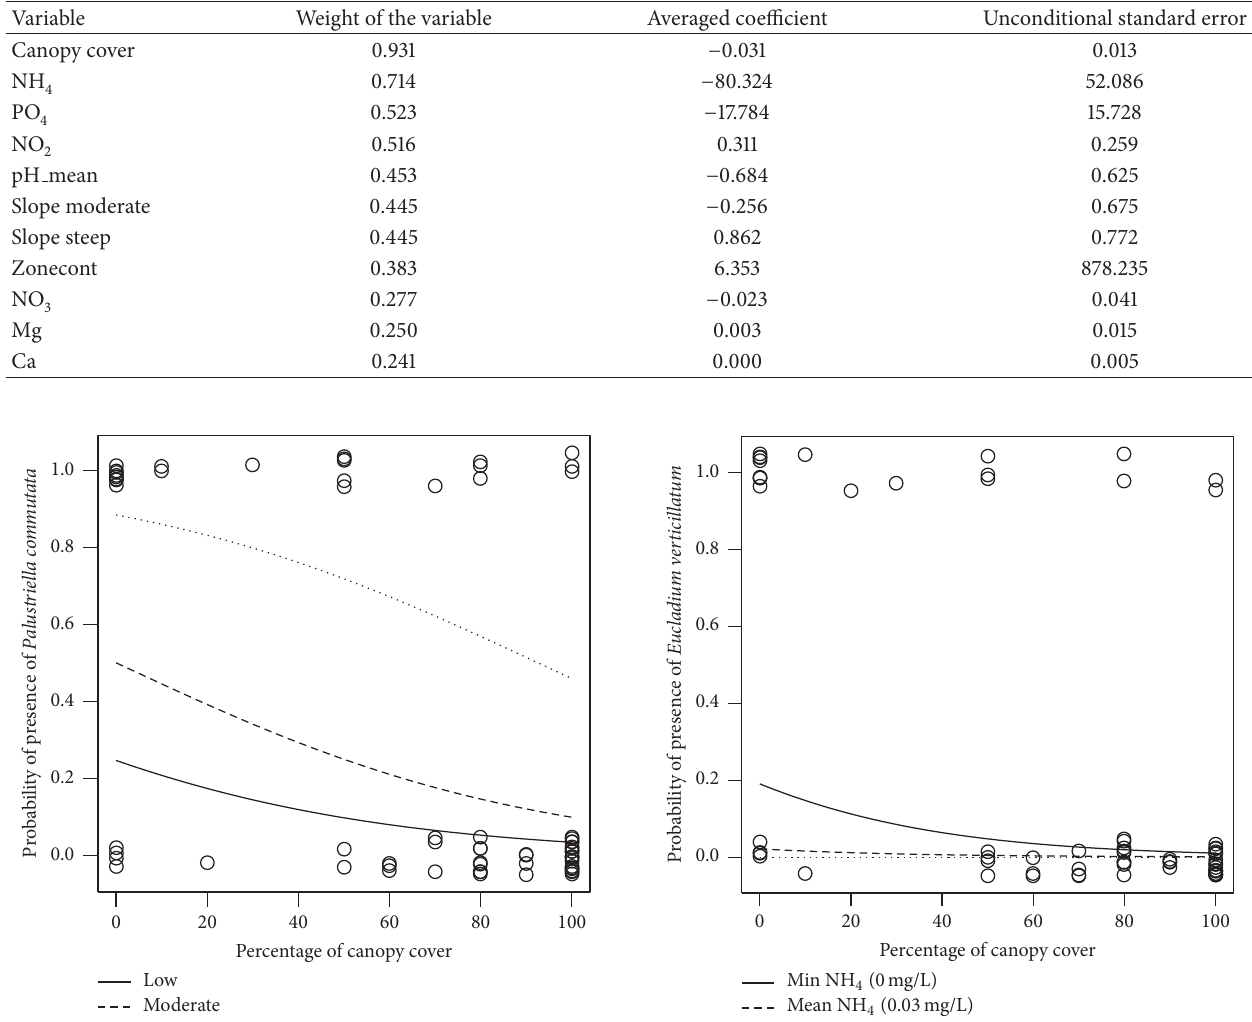
Table 5: Results of the AIC stepwise model selection for probability of presence of Eucladium verticillatum showing the best significant variables selected based on their weight using the complete dataset.